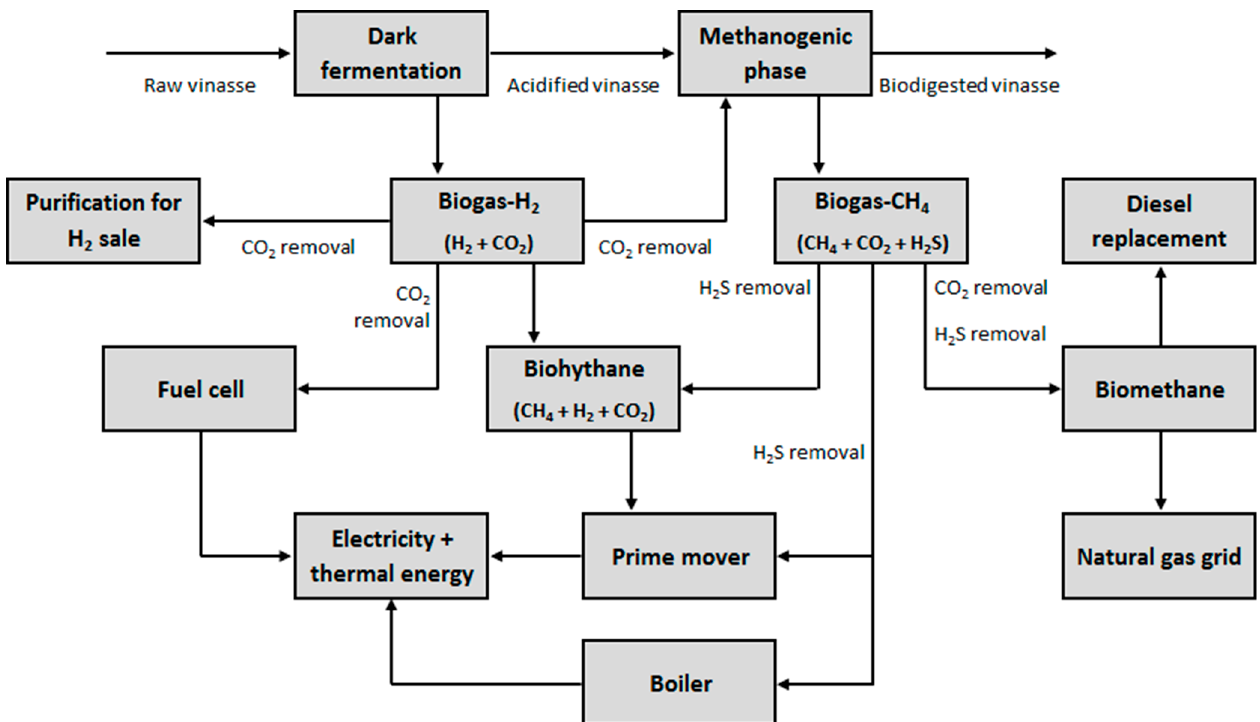
Figure 4. Potential applications for the biogas streams from biodigestion with phase separation.